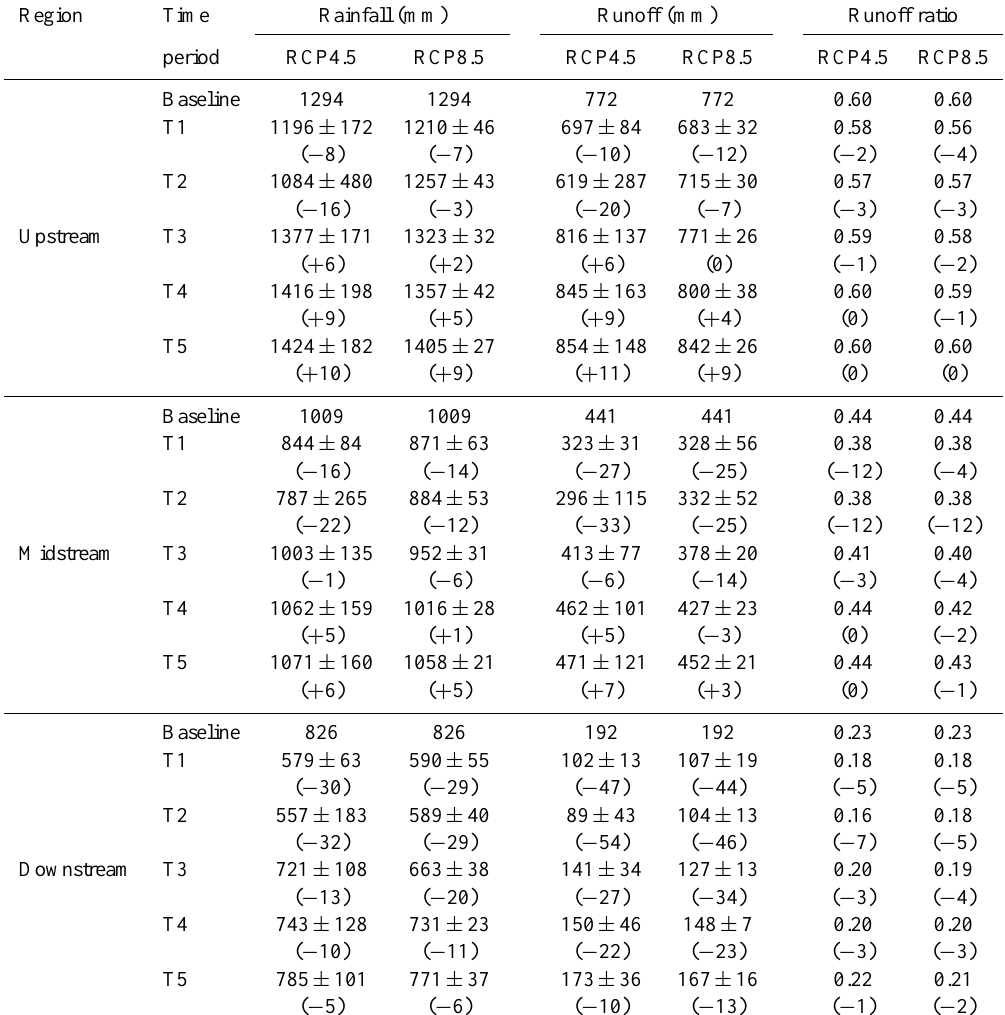
Table 5. Runoff ratio across time slices for upstream, midstream and downstream regions (terms in parentheses indicate the percent change from the baseline